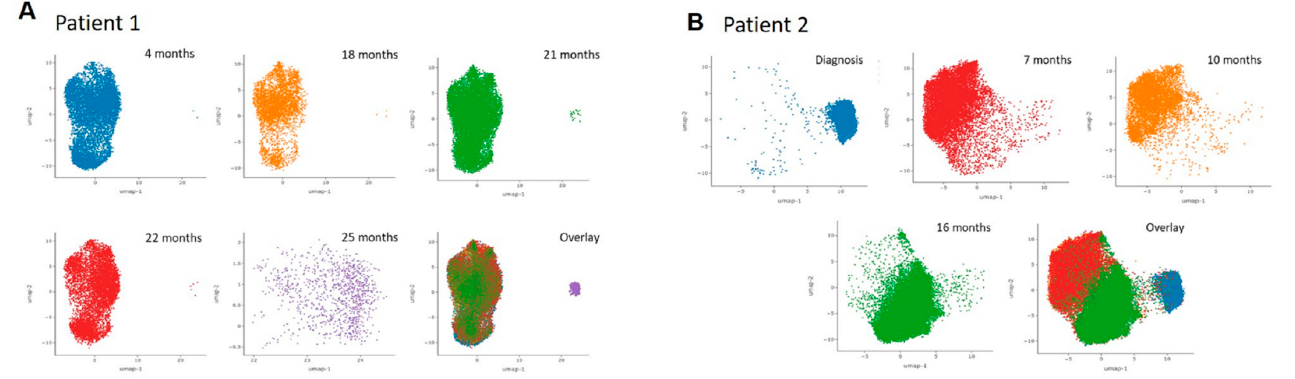
Figure 4. Heterogeneity of overall copy numbers during treatment by Principal Component Analysis (PCA) and Uniform Manifold Approximation Projection (UMAP) analysis. ( A ): Patient 1 at 4 months (after 4 cycles of AZA), at 18 months (at progression to secondary AML after 18 cycles of AZA), at 21 months (at relapse after the first cycle of midostaurin and high-dose cytarabine consolidation), at 22 months (non-remission to one cycle of venetoclax-DEC) and at 25 months (non-remission after 3 months of Gilteritinib); ( B ): Patient 2 at diagnosis, at 7 months (before the first cycle of AZA), at 10 months (after 3 cycles of AZA), and at 16 months (at progression to secondary AML leukemia after 9 cycles of AZA).